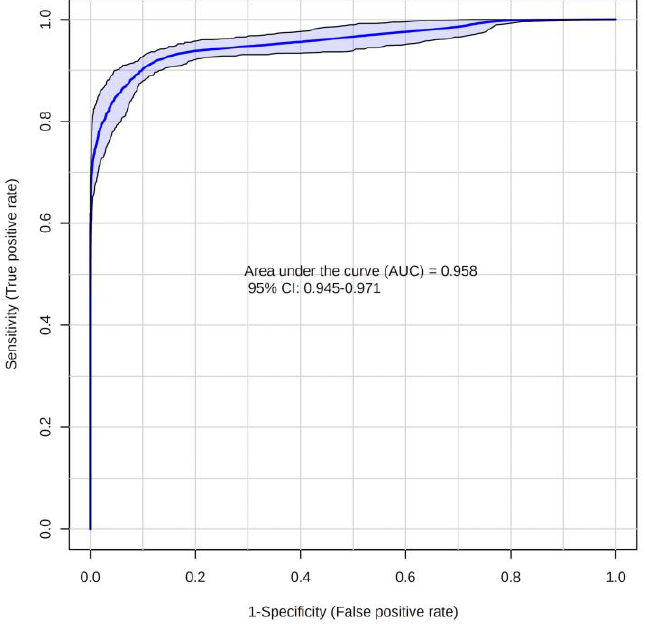
Figure 3. Heatmap analysis of the selected metabolites depending on the meningioma (MGM) group class (represented by the red/green horizontal bar on the top of the graphic). HG, High-grade; LG, Low-grade. The color grade represents the intensity of each biomarker in the patient samples.